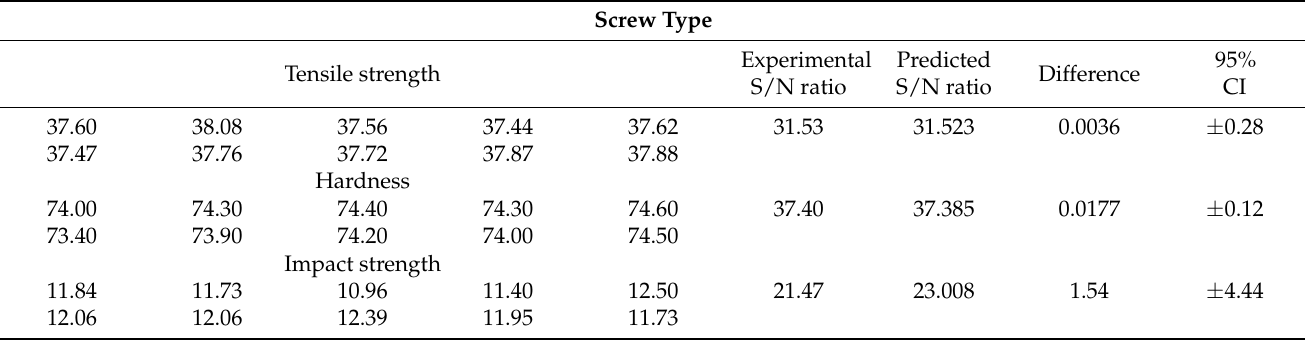
Table 4. Experimental values of single-quality optimal parameters